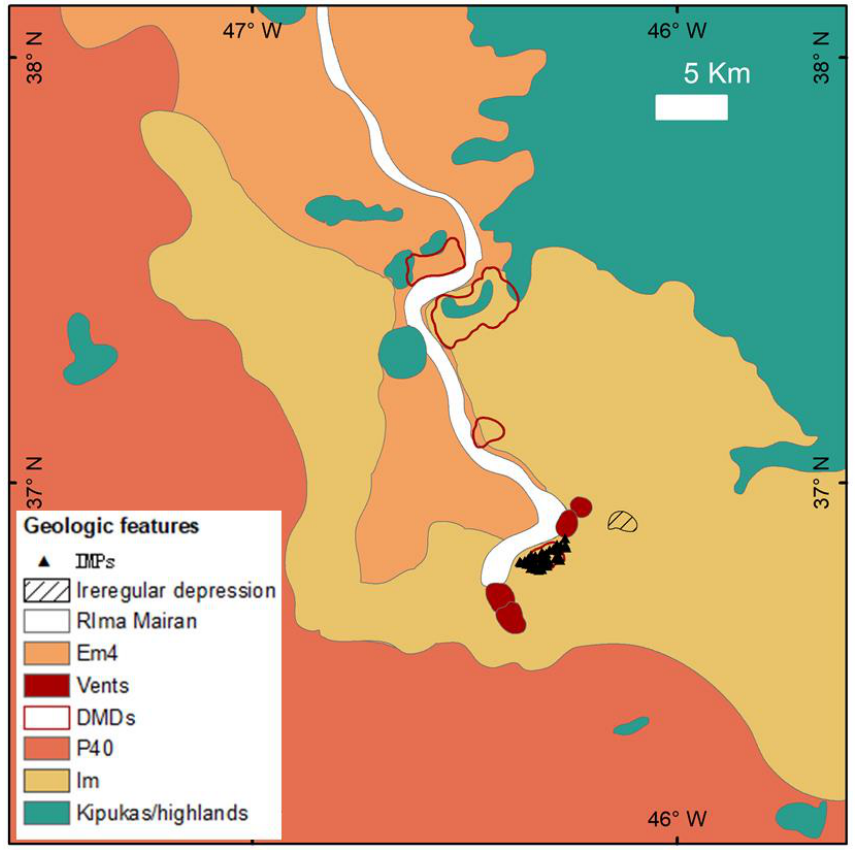
Figure 6. A sketch of the local geologic map.